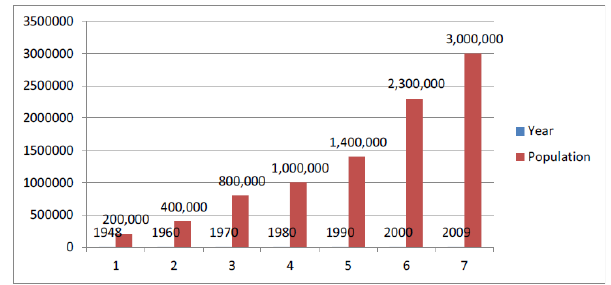
Figure 2. The urbanization trend in Nairobi (Akelola,